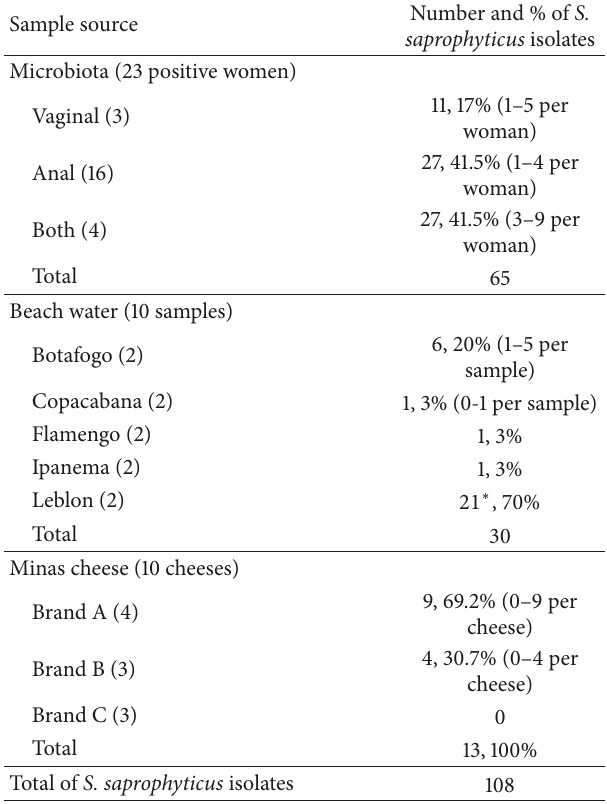
Table 2: Distribution of Staphylococcus saprophyticus isolates obtained from pregnant women’s microbiota, beaches, and minas cheese in Rio de Janeiro